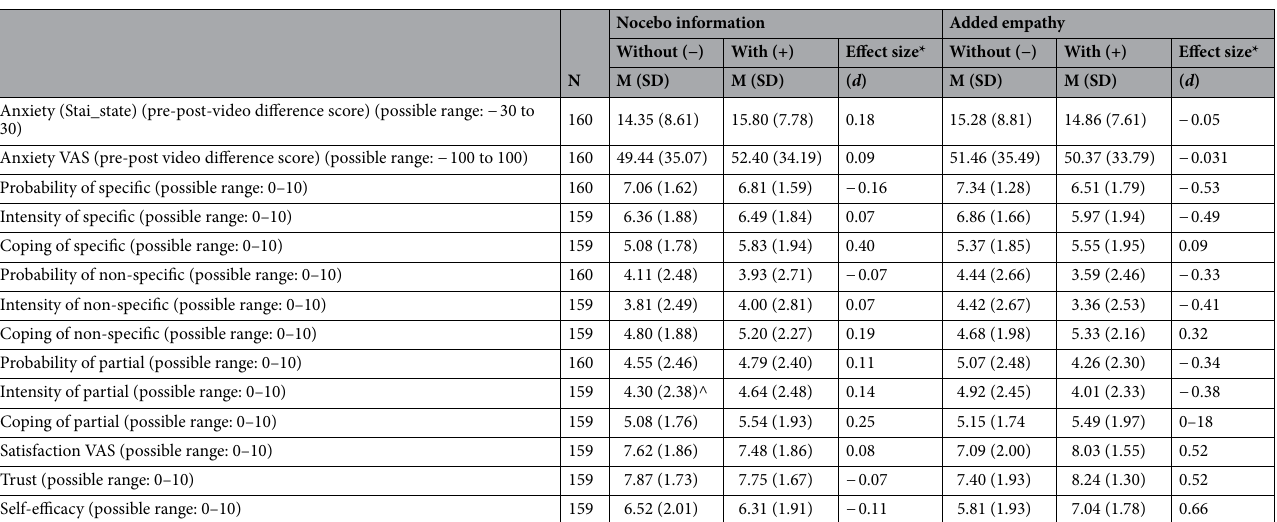
Table 5. Raw uncontrolled mean scores and effect sizes of nocebo information condition and empathy condition on all outcomes. *Effect sizes are positive when the condition (with vs. without) has a positive effect. The effect sizes are